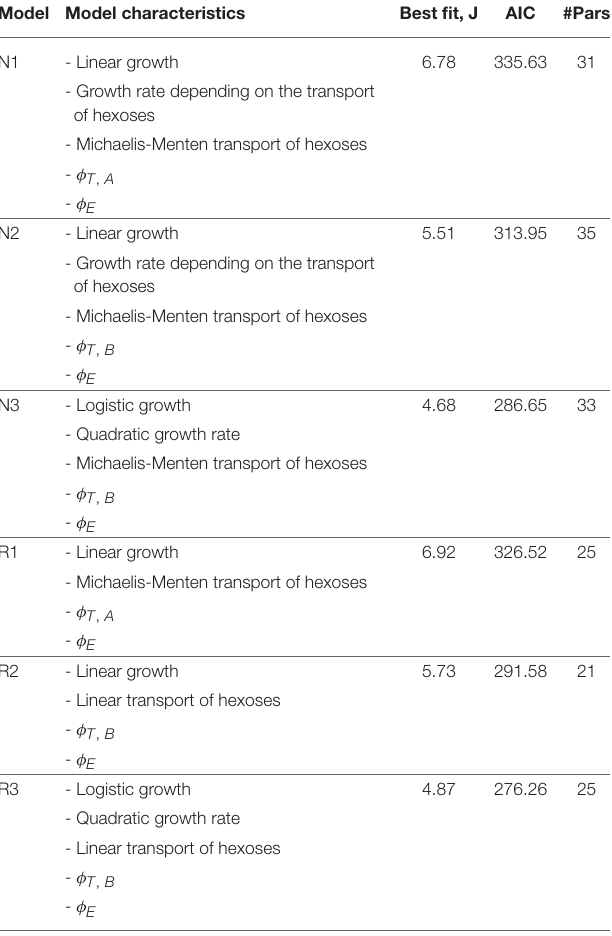
TABLE 1 | Major characteristics and best fist statistics for nominal models and final reduced